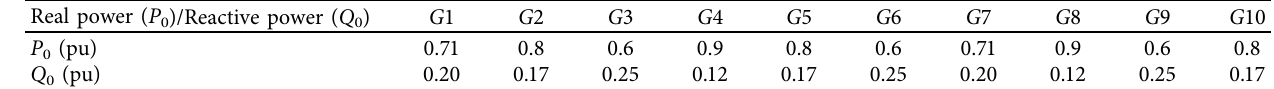
Figure 21: 39 bus system. Table 9: Initial operating condition for hydro generators for 39 bus system.